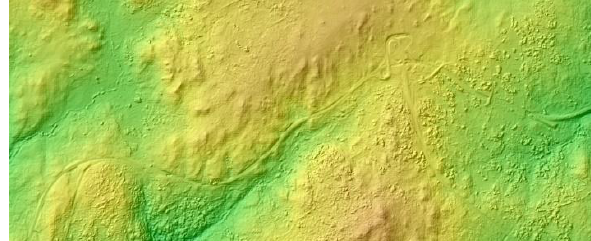
Figure 5. Representation of the DSM with pixel size of 1 meter obtained from aerial photographs.